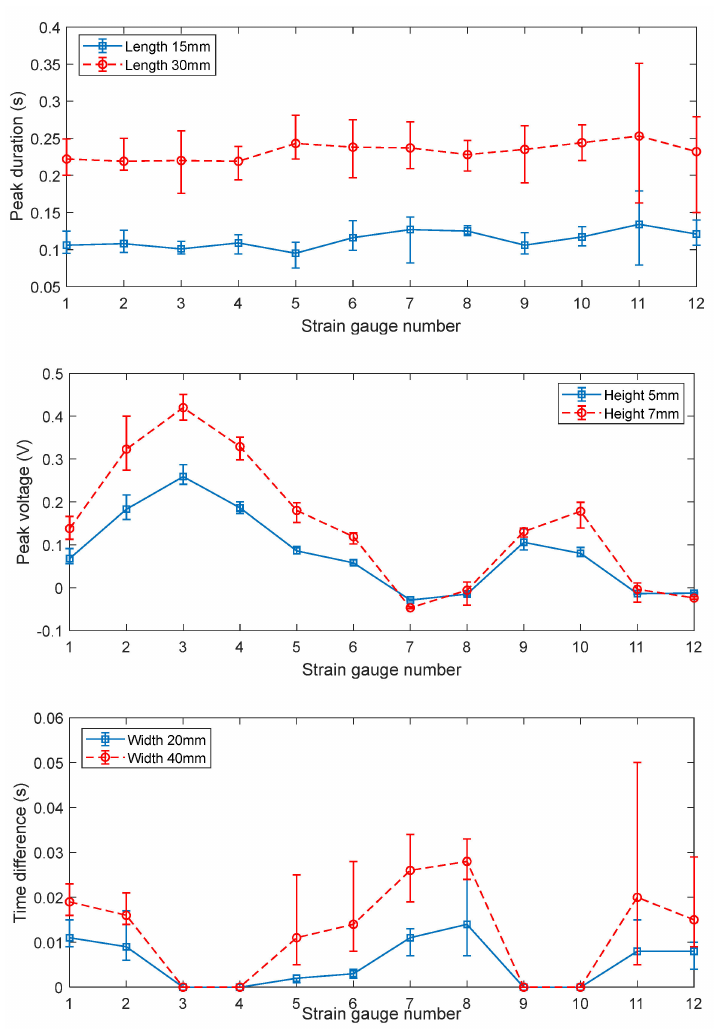
Figure 11. Features analysis. Note: ( top ) signal peak duration, ( mid ) peak voltage, and ( bottom ) signal initiation time difference referenced to the central positions (m, n in Figure 3). The error bar denotes the bounds that contain 5 separated tests under the same